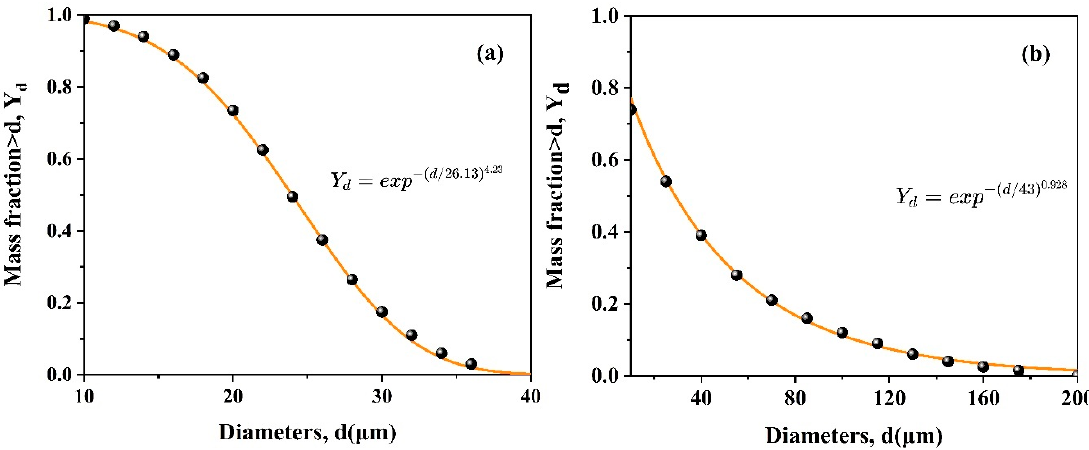
Figure 3. Rosin–Rammler droplet size distribution at the inlet of cyclone separator ( a ) B and ( b ) D 1 . Using the commercial CFD software Fluent, the variables on the surface of the control body were interpolated using the second-order upwind format. The governing